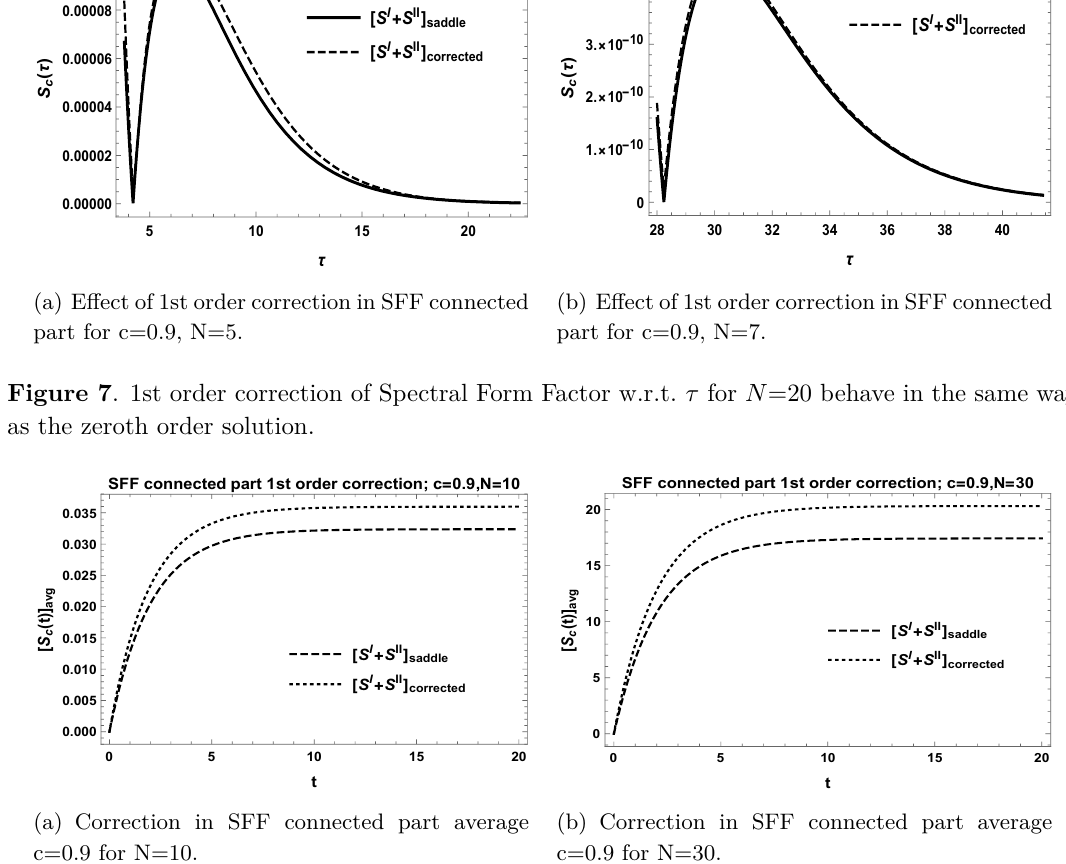
Figure 8 . 1st order of correction in SFF connected part average over interval [0,t] from eq. (3.4). points. Considering the second term of eq. (3.4) we have added the correction term in